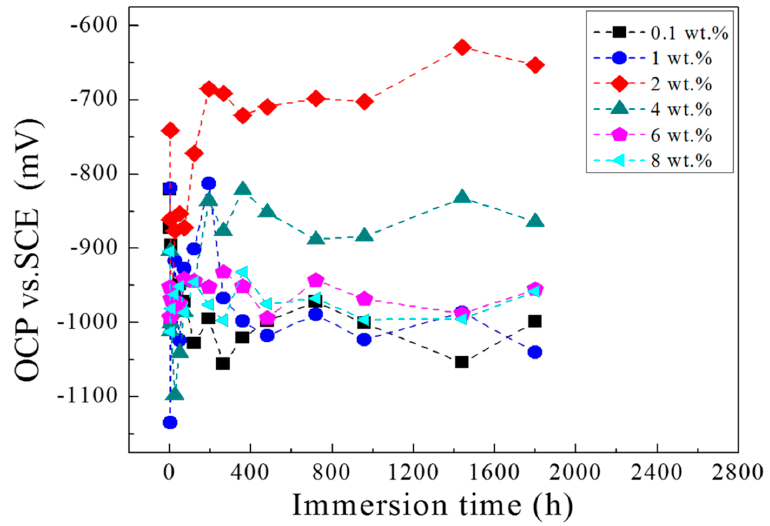
Figure 1. OCP (open circuit potential) curves for different concentration of PANI-SSA coated 5083 aluminum in 3.5% NaCl solution for 80 days.